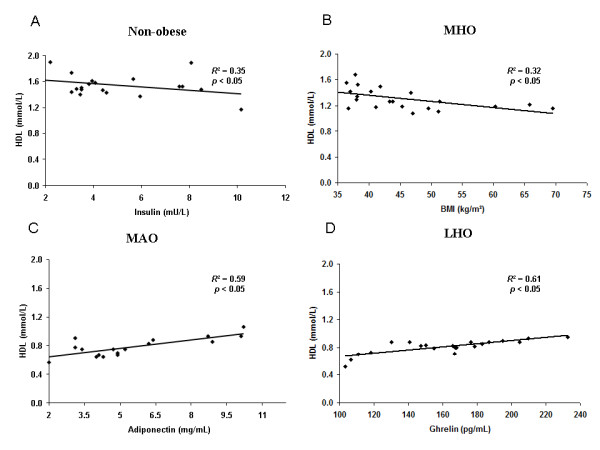
Association in stepwise regression analysis between plasma HDL-c levels and several parameters in non-obese and obese subjects. Relationships between HDL-c levels and: plasma insulin in non-obese control subjects (A); body mass index (BMI) in metabolically healthy obese (MHO) patients (B); serum adiponectin in metabolically abnormal obese (MAO) patients (C); serum unacylated ghrelin in isolated low HDL-c obese (LHO) patients (D).